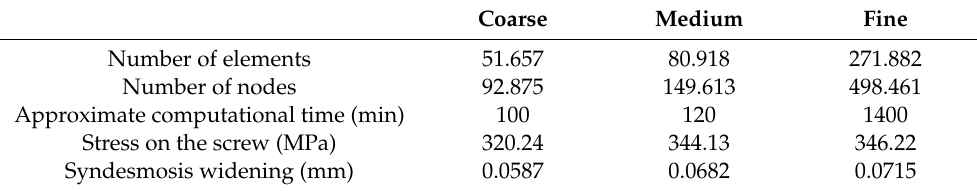
Figure 2. Classification according to the mesh densities to evaluate the sensitivity of the elements: ( a ) shows the coarse mesh, ( b ) shows the medium mesh, and ( c ) shows the image of the fine mesh. Table 4. Analysis of state and influence on interpretation by mesh densities.